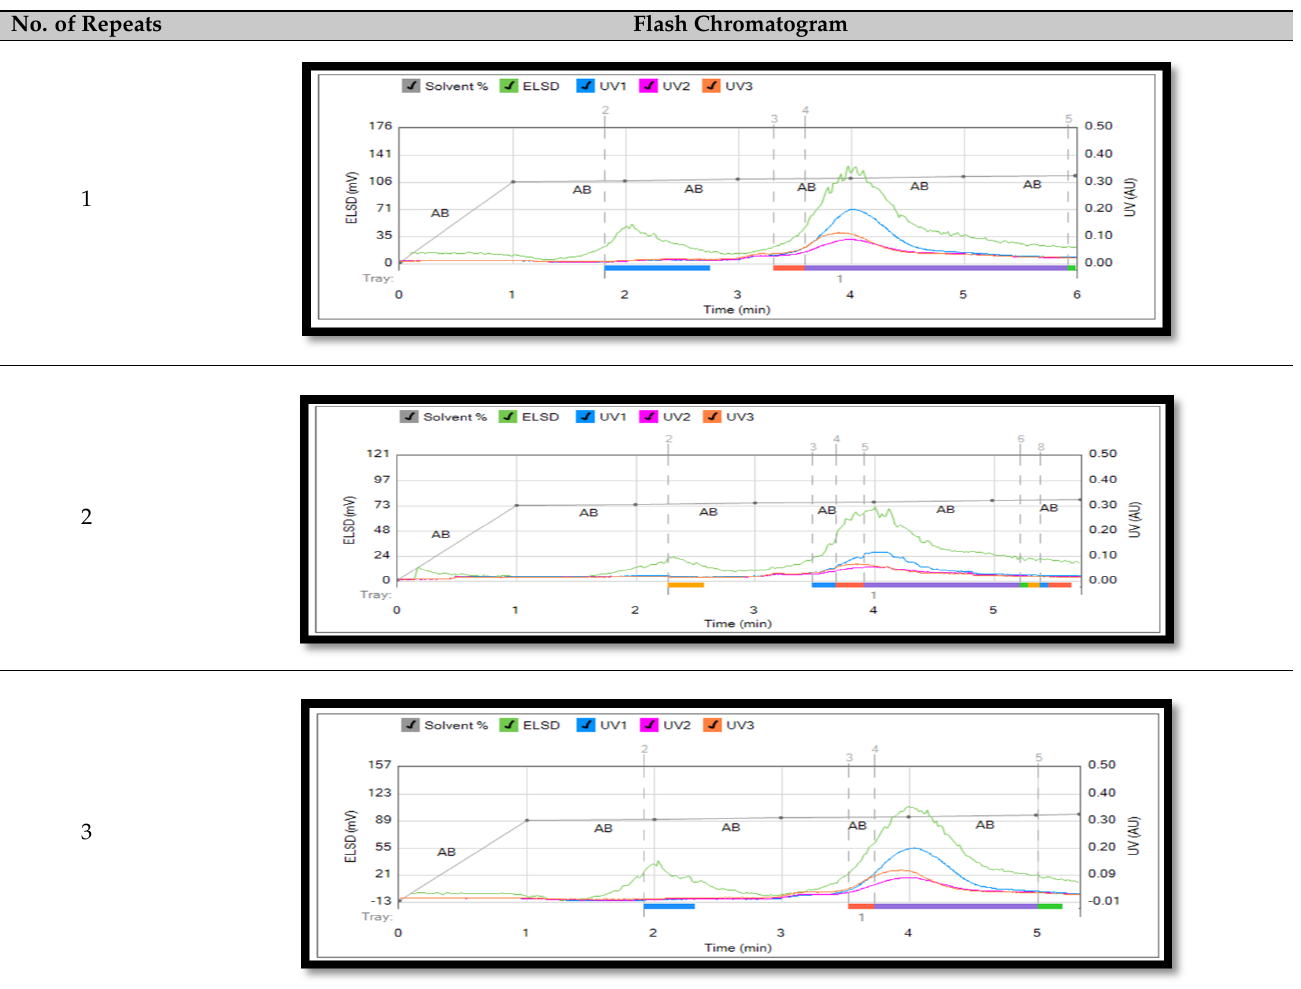
Table 3. Demonstrates the number of repeats conducted for run 8.